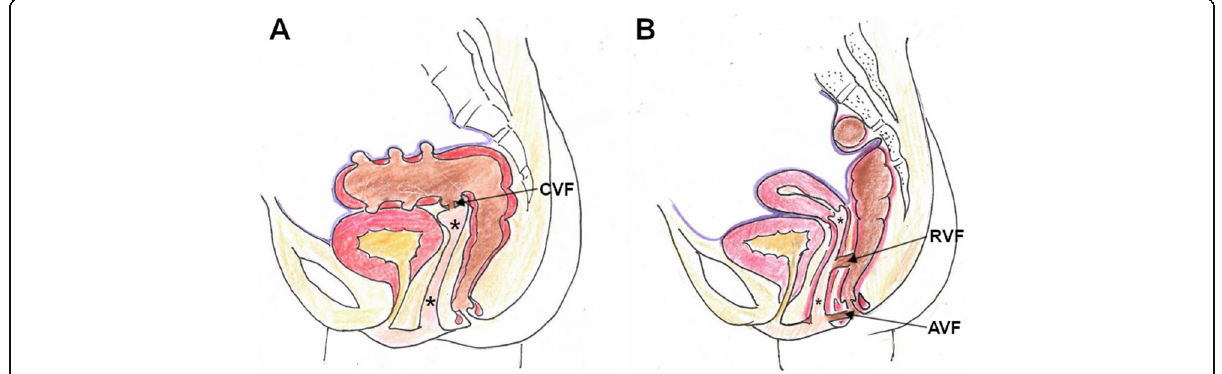
Fig. 1 Schematic representation of entero-vaginal fistulas (VF). a colo-VF (CVF). b recto-VF (RVF) and ano-VF (AVF). Note absent uterus in ( a ). Vagina indicated by asterisk (*), urine in yellow, stools in